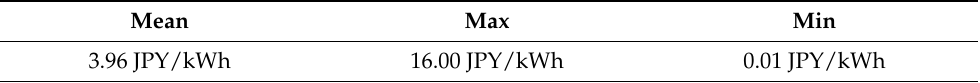
Table 4. Mean, maximum, and minimum values of bid-ask spreads (without market